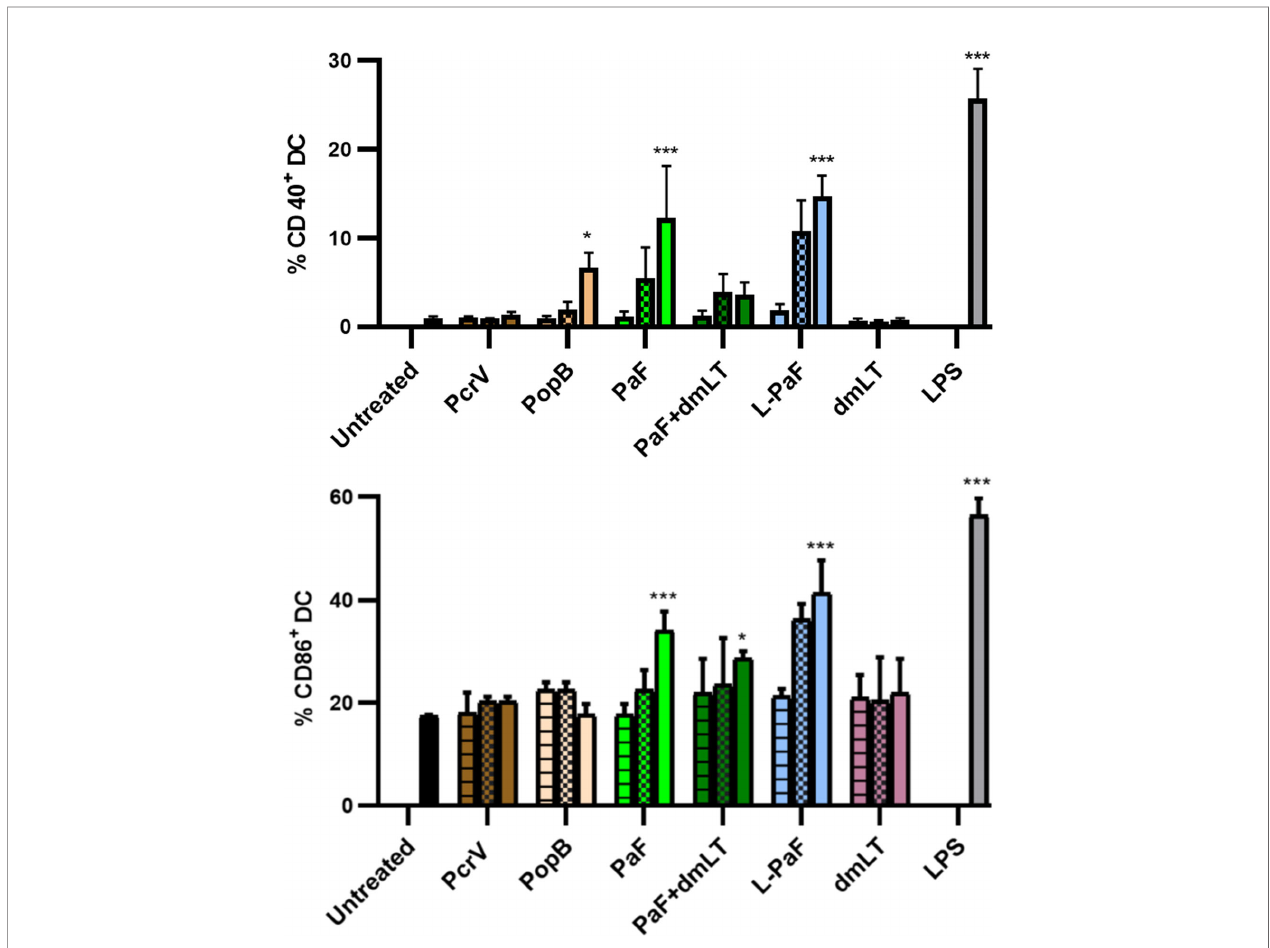
FIGURE 1 | Assessment of LTA1-GSAAS-PaF (L-PaF) effects on Bone marrow dendritic cell (BMDC) maturation. Mouse BMDCs were untreated or treated for 32 h as indicated with low (horizontal stripes), medium (checkerboard), or high (solid) concentrations of the indicated proteins. For L-PaF the protein concentrations used were 1.0, 0.1, and 0.01 µg/ml. To ensure the same molar amount of antigen present, for PaF alone, we used 0.77, 0.07, and 0.007 µg/ml. Approximately half of the latter amounts were used for stimulation with PcrV and PopB alone to give equivalent molar concentrations. Salmonella enterica Typhimurium LPS (made by Westphal method in the Picking lab) was used at 10 µg/ml. Co-staining of CD11c (DC marker) with the maturation markers CD40 + (top), CD86 + (bottom) was determined by fl ow cytometry as a measure of dendritic cell maturation. Results are represented as average of triplicates with these results being representative of fi ve independent experiments. Signi fi cance was calculated by comparing to untreated groups using two-way ANOVA. *p < 0.05; ***p <